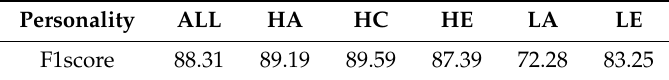
Table 3. Comparison of basic sentiment classifiers.